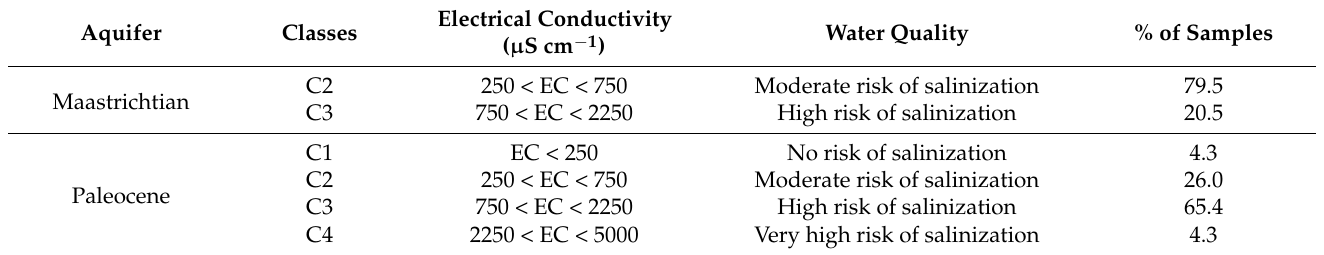
Table 3. Classification of groundwater aquifer by measured electrical conductivity